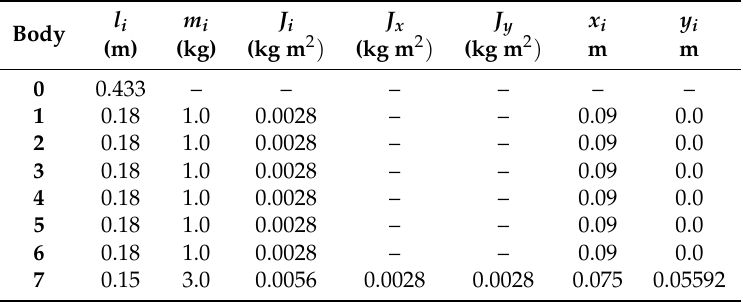
Table 1. Parameters of an specific 3RRR planar parallel manipulator